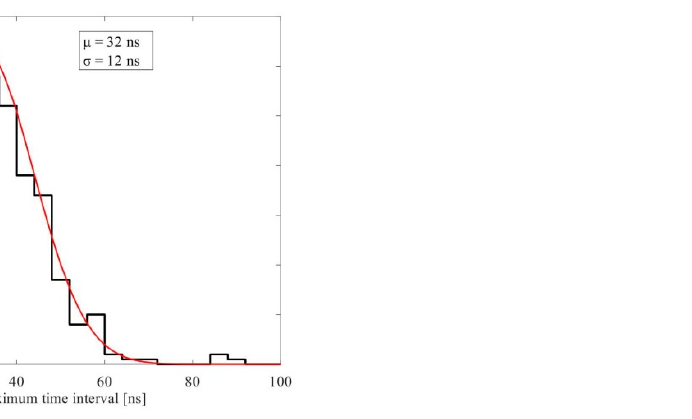
Figure 5. Distribution of 471 coincidence events registered by TOP, BOTTOM, FRONT and REAR detectors. To obtain the data, a Gaussian distribution has been fitted (µ = 32 ns; σ = 12 ns).